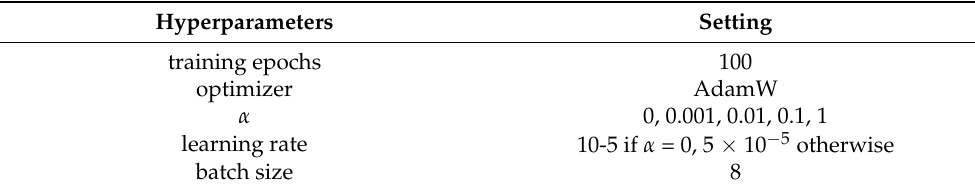
Table 6. The hyperparameters used for fine-tuning.